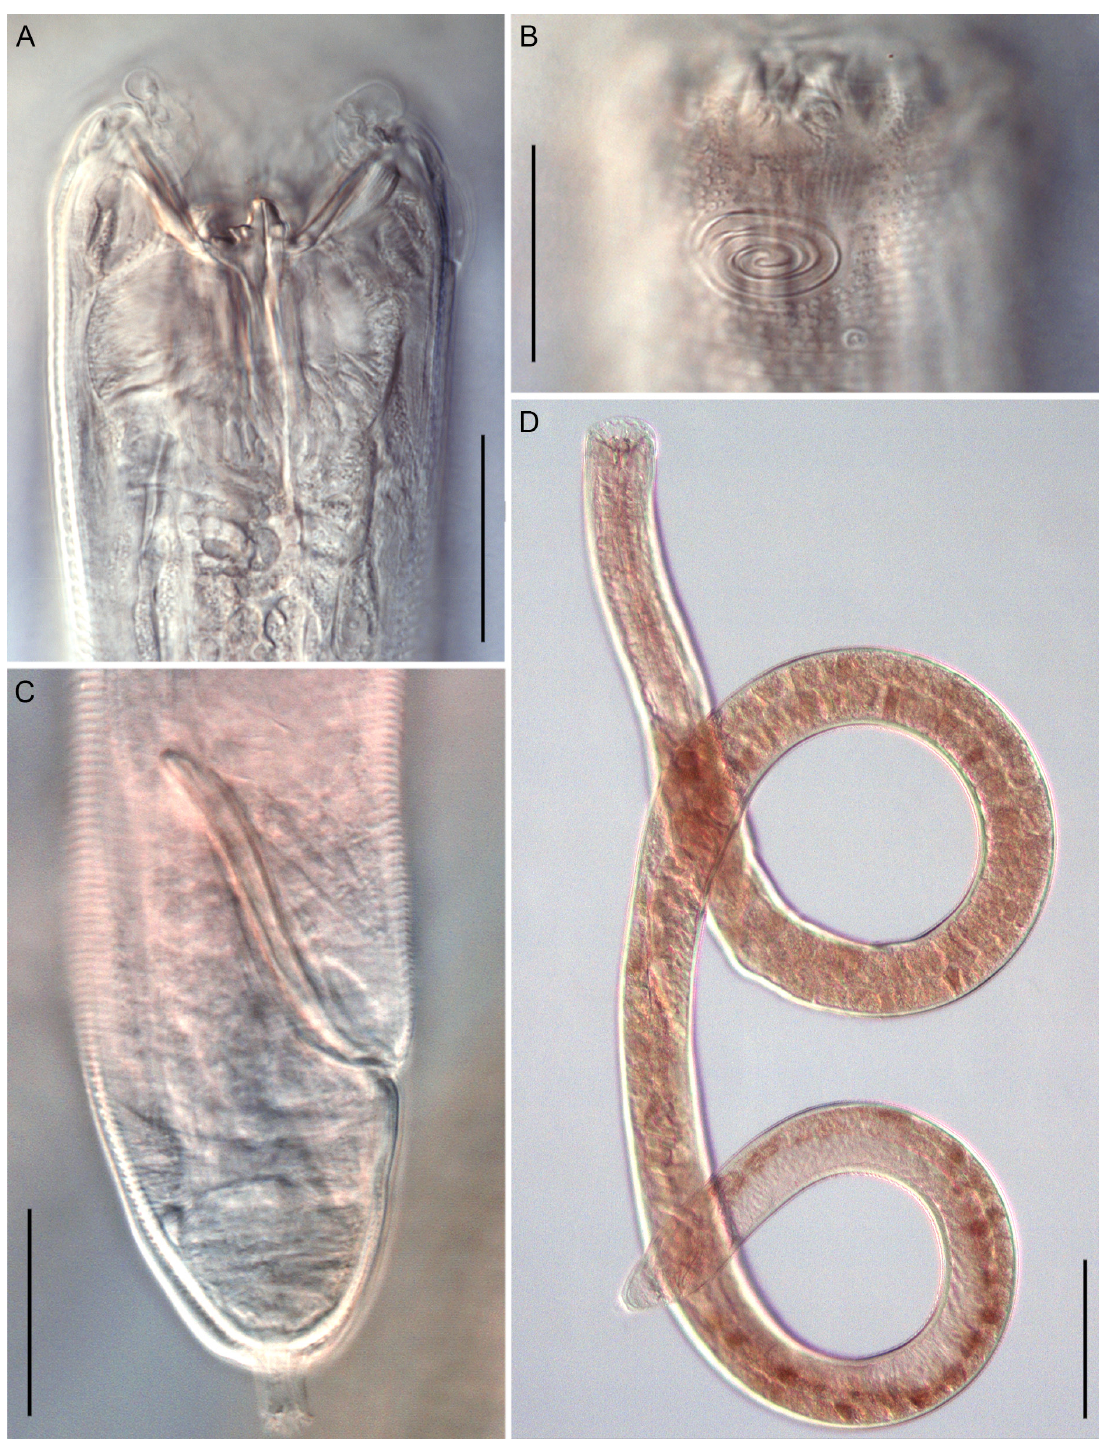
Fig. 6. Synonchium caudatubatum sp. nov. holotype, ♂ (A–C) and a paratype, ♂ (D). A–B . Head, showing the papillate sensilla, transverse oval amphideal fovea, transverse rows of punctuations, lateral cuticle pores, the broad anterior buccal cavity and narrow posterior buccal cavity with three mandibles each with seven teeth, and the swelling anterior end of pharynx. C . Tail, showing the almost straight spicules without gubernaculum, and the bluntly rounded tail with a protuberant caudal duct. D . Overview, showing the slightly slender body. Scale bars: A–C = 30 µm, D = 100